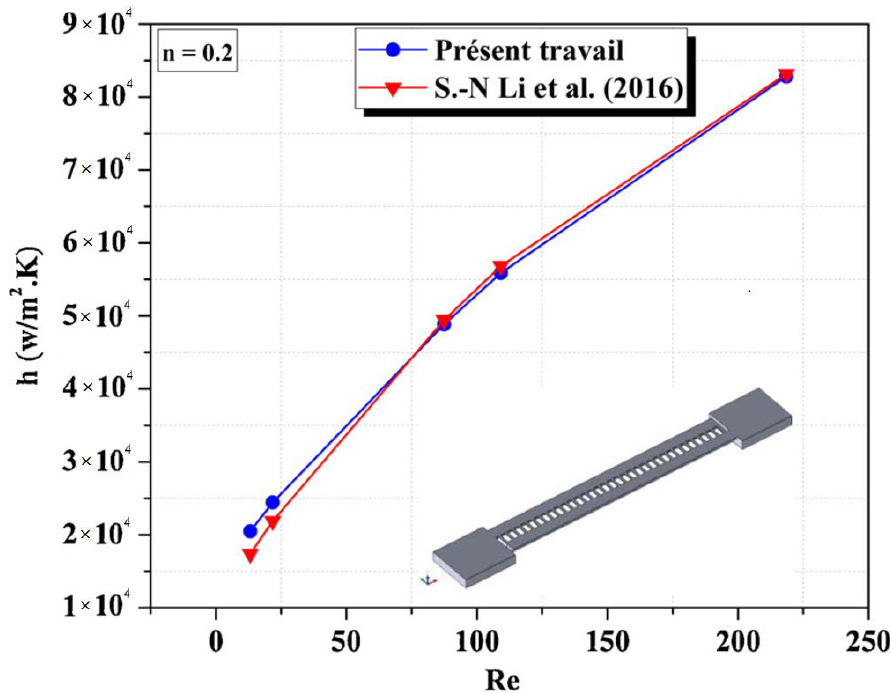
Figure 5. Heat transfer coefficient Vs Reynolds number for non-Newtonian case with Li et al. reproduced with permission from [43].